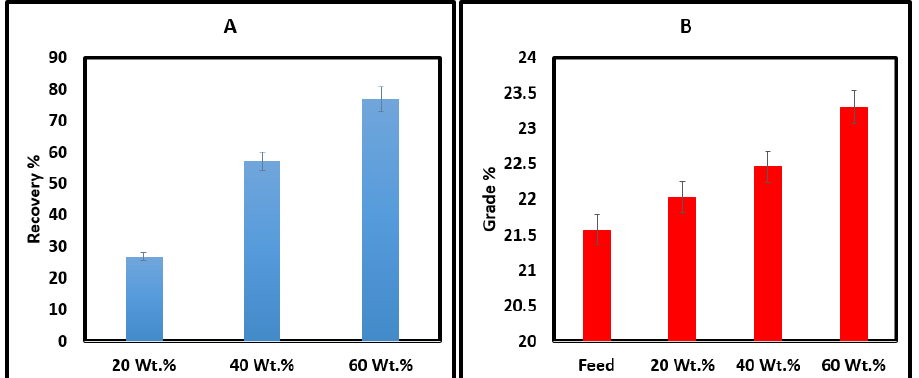
Figure 10. ( A ) Flotation recovery and ( B ) P 2 O 5 grade (%) of concentrate products obtained from baseline experiments at different solid content.